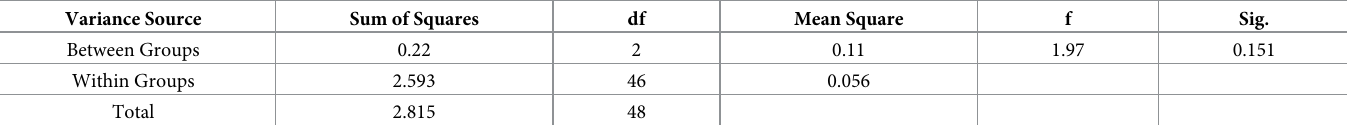
Table 11. The ANOVA test results for analyzing the means of the physics teachers’ responses to the years of experience variable. Variance Source Between